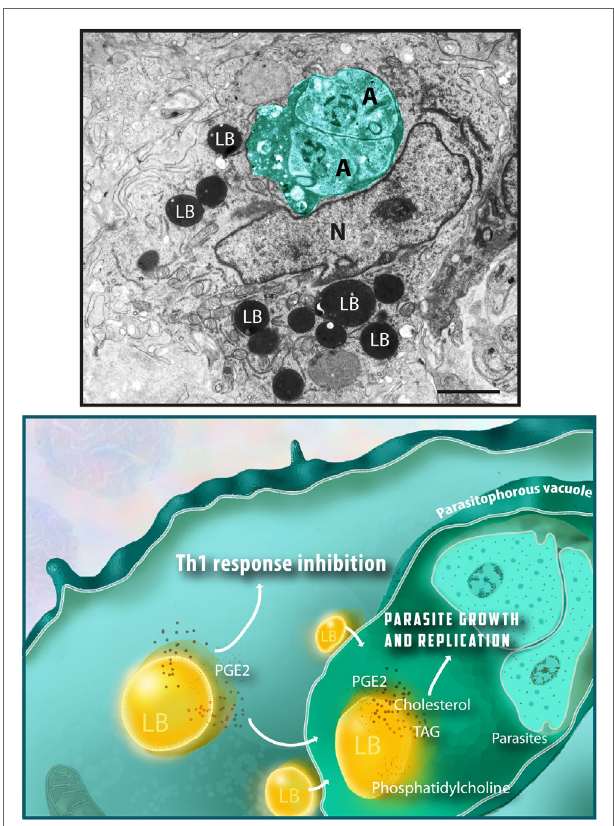
FiGURe 1 | Lipid bodies (LBs) accumulate in the host cell cytoplasm in response to interaction with protozoan parasites and favor parasite survival . Top panel shows an electron micrograph of a heart inflammatory macrophage infected with Trypanosoma cruzi . Note the presence of dividing amastigotes (A) within the parasitophorous vacuole (outlined in green) and the high number of LBs in the cytoplasm. LBs typically appear as round electron dense organelles in the cell cytoplasm. A model to explain how protozoan parasite-induced LB formation favors parasite growth and replication is shown in the bottom panel. Interaction of LBs with the parasitophorous vacuole, an event also triggered by the parasite infection, leads to discharge of LB contents, such as cholesterol, triacylglycerol (TAG), and phosphatidylcholine, which serve as lipid sources for parasite growth. Newly formed LBs are also sites for prostaglandin E2 synthesis (PGE2), a potent inflammation mediator that potentially inhibit the host Th1 immune response, thus decreasing the microbicidal capacity of the parasitophorous vacuole. Nu, nucleus. Scale bar, 600 nm. Top panel was reprinted from Ref. (27) with permission.